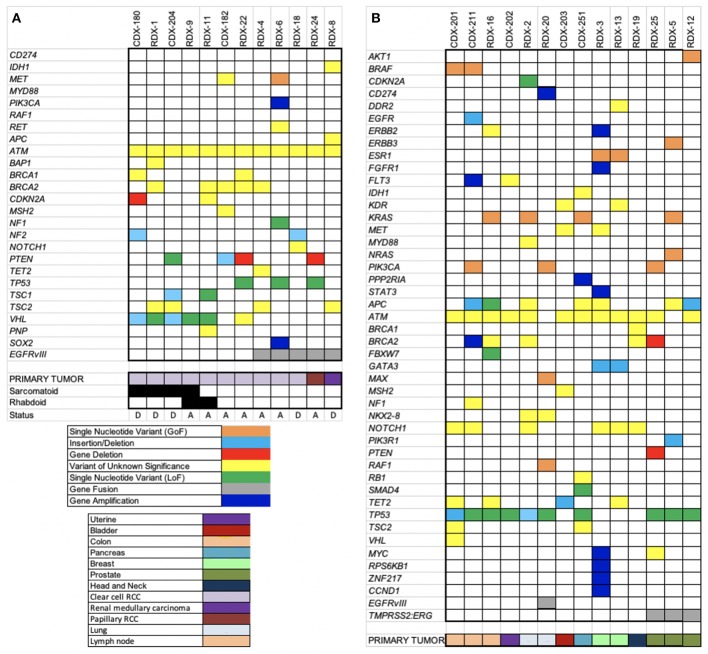
Heatmaps of somatic alterations detected. OCAv1 identified relevant somatic alterations in the 26 solid tumor registry specimens, including cases with RCC (A) and other types of cancers (B). All relevant high-priority molecular alterations, including SNVs, indels, CNAs, fusions, and variants of unknown significance, are shown in the heat map. Specific alterations and cancer types are shown at the bottom of the heat maps according to the keys.